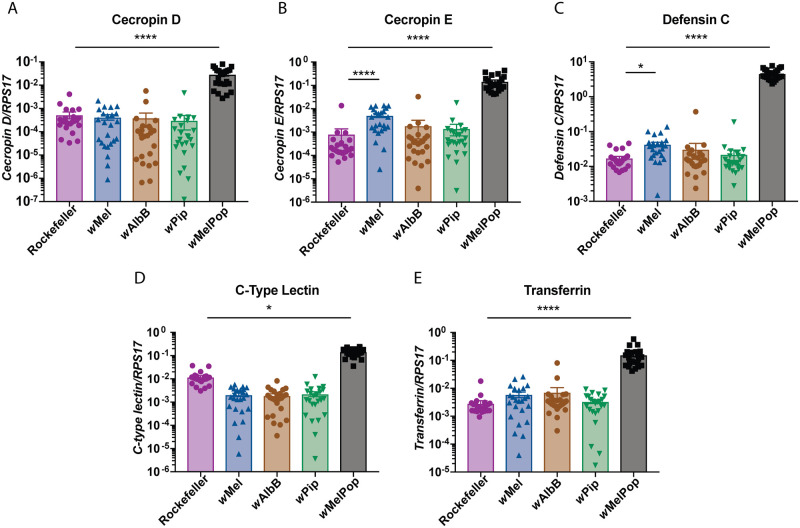
Elevated innate immune response pathways are not required to mediate viral inhibition.(A-E) Expression levels of selected genes from innate immune pathways were measured by qRT-PCR in 5-day old female mosquitoes, relative to the Ae. aegypti host RPS17 gene. Data are the mean and SEM of 24 mosquitoes, representative of 2 independent experiments. Asterisks indicate significance compared to Rockefeller (no Wolbachia control) (Kruskal-Wallis test with Dunn’s correction; *p<0.05, ****p<0.0001).